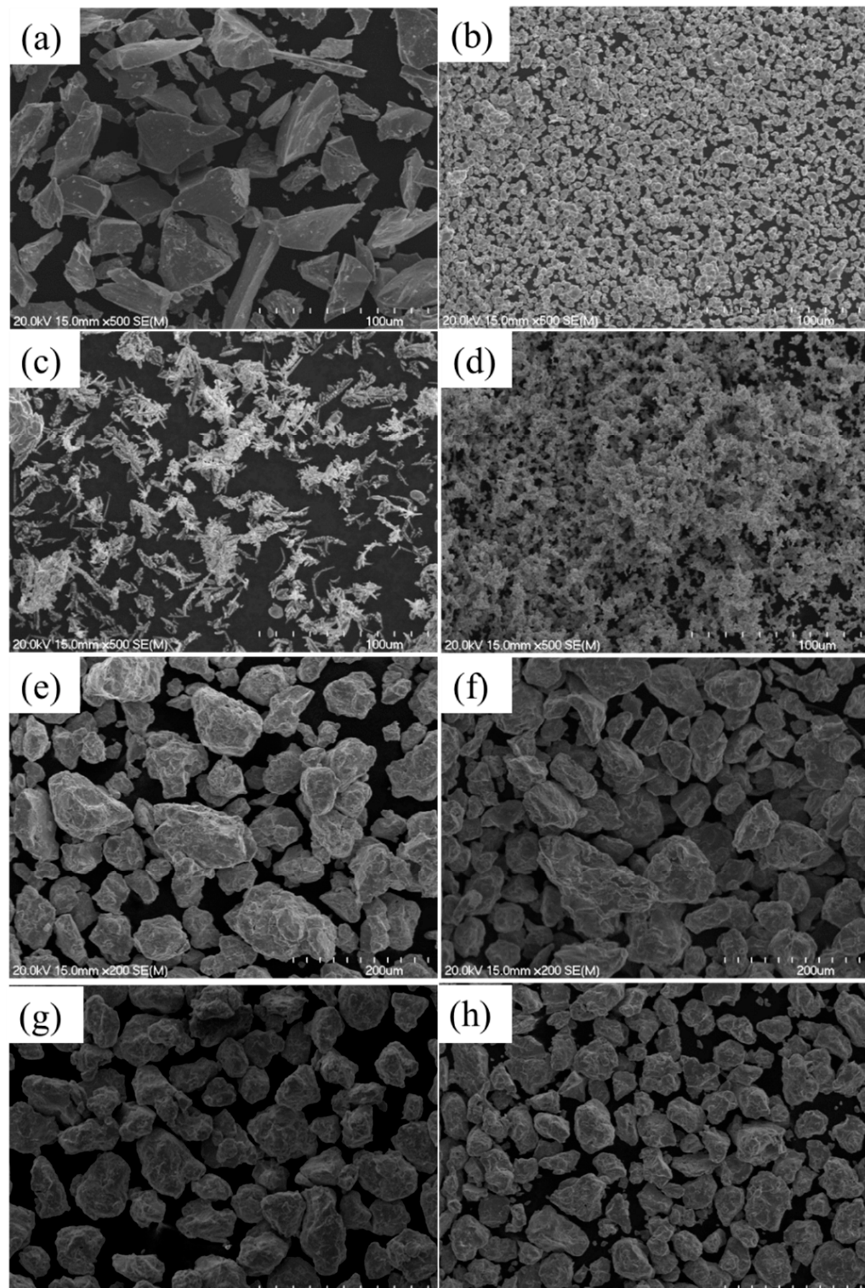
Figure 2. SEM micrographs of raw elemental powders and as-milled HEA NiMnFeCu at various time intervals. ( a ) Mn, ( b ) Fe, ( c ) Ni, ( d ) Cu, ( e ) 5 h, ( f ) 10 h, ( g ) 15 h, ( h ) 20 h.